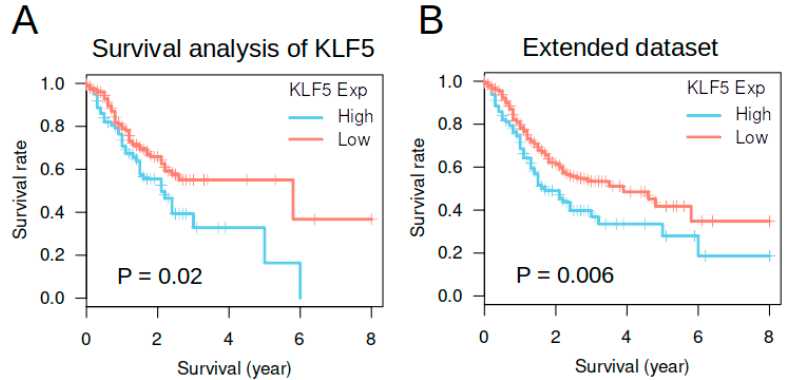
Figure 5. Survival analysis of KLF5 expression in gastric cancer from TCGA dataset. ( A , B ) showed the Kaplan–Meier plots of survival analysis. P -values in the figures were calculated by log-rank tests. ( A ) came from a smaller dataset containing 278 patients with molecular classification, whereas ( B ) came from an extended dataset containing 414 patients with good follow-up data.